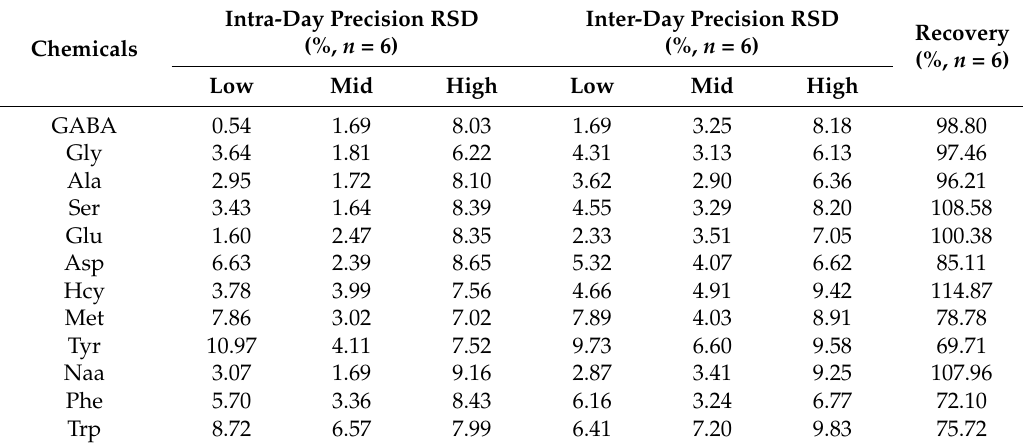
Table 3. Determination of neurotransmitter concentrations by HPLC-MS/MS: validation results for precision and recovery.